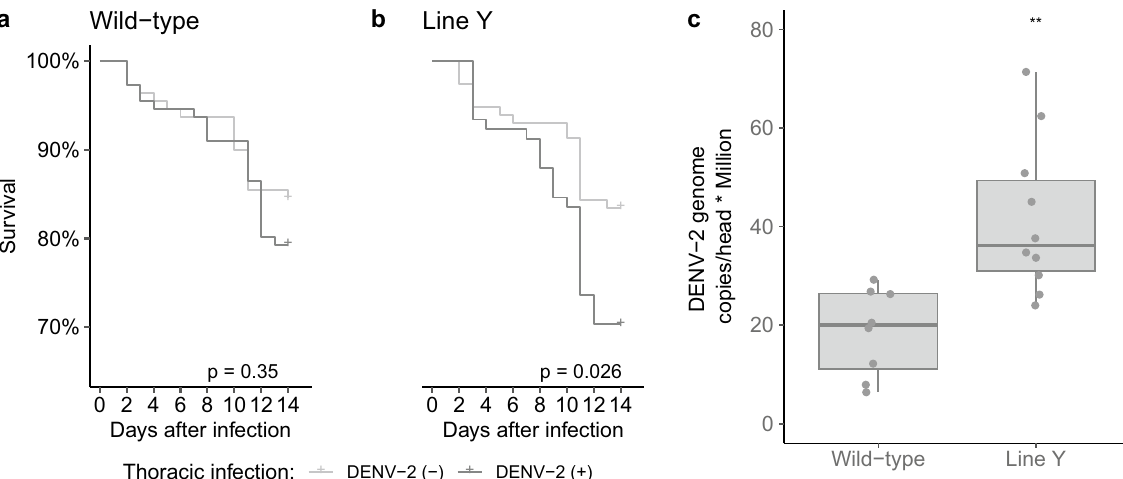
Figure 4. Survival and viral load of transgenic line Y following intrathoracic infection with DENV-2. ( a ) Kaplan–Meier survival curve based on the Log-rank test between the non-infected and infected control group (HWE strain, “wild-type”) and ( b ) the non-infected and infected transgenic line Y. Survival curves were performed for 15 days. Crosses represent censored data at the end of the lines. ( c ) Median number of DENV-2 RNA copies/head (per million) detected at 15 days DPI in control (HWE, “wild-type”) and line Y mosquitoes using the GLM procedure and the estimated marginal means (least squared mean), with Tukey contrasts multiple comparison method to determine statistical differences—boxplot represents the median, minimum and maximum, and 25% and 75% quartiles; points represent a scatter plot of their distribution.